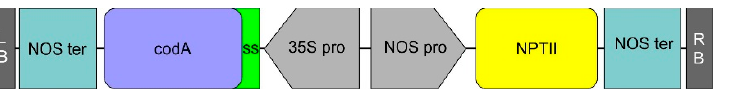
Figure 1. The choline oxidase expression cassette. codA —choline oxidase gene with transit peptide ss; NPTII—neomycin phosphotransferase gene; NOS pro—nopalin synthase promoter; NOS ter— nopaline synthase terminator; 35S pro—promoter of cauliflower mosaic virus (CaMV) 35S RNA; RB and LB—right and left border sequences of T-DNA.